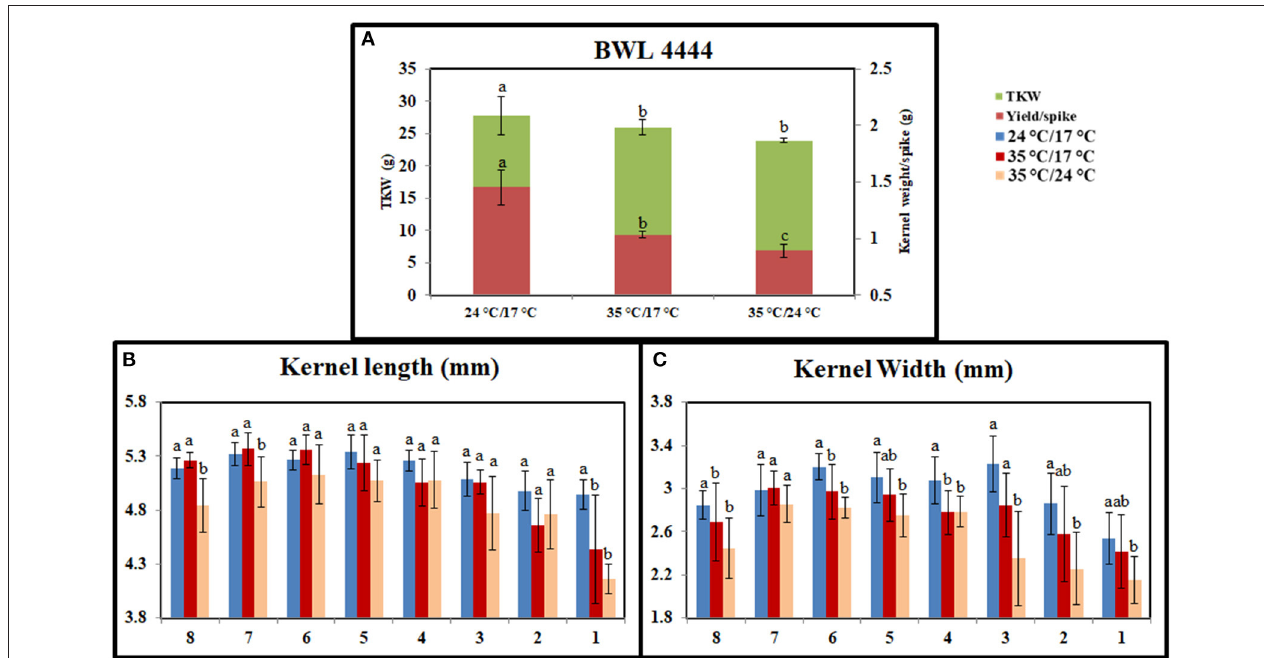
FIGURE 2 | Graph representing the effect of heat stress during grain-filling period on yield parameters between control, day heat stress, and day–night combined heat stress. (A) Kernel weight/spike in grams (g) and thousand kernel weight (TKW) in grams (g). (B) Kernel length (mm). (C) Kernel width (mm). The x-axis in (B,C) indicates bottom spikelet (8) to top spikelet (1). Values were given in Mean ± SE. Variables with the same letter are not significantly different from each other at P ≤ 0.05.